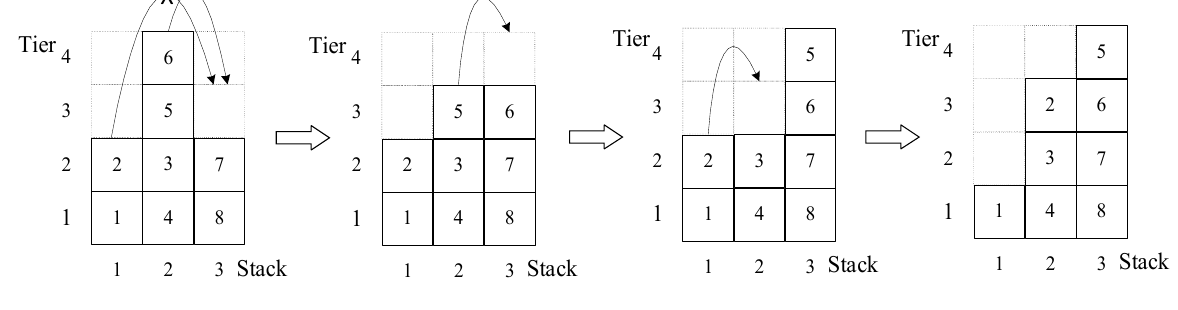
Figure 2. Relocation process.